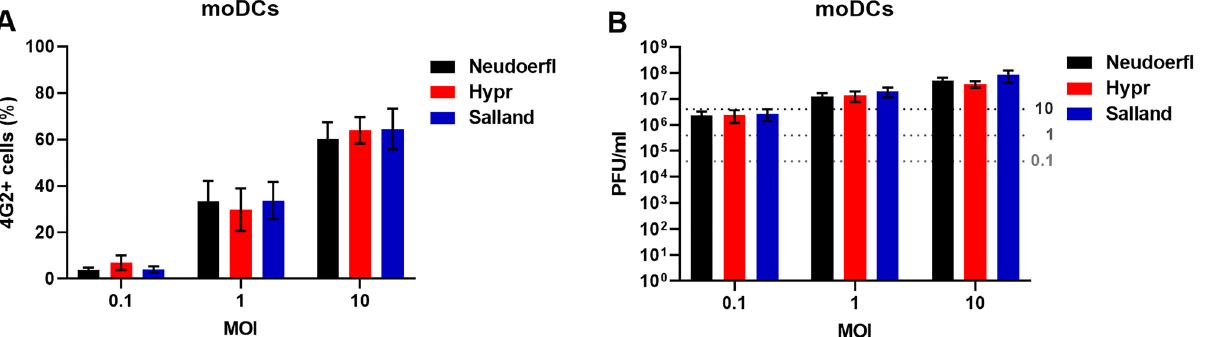
Figure 4. TBEV infection of moDCs. moDCs of three individual donors were infected with the different TBEV strains at various MOIs for 26 h. ( A ) Percentage of TBEV infected cells as quantified by fluorescent microscopy. ( B ) Infectious virus production as assessed by plaque assay. The inoculum titers per infection condition (MOI) are indicated by dashed grey lines. All values indicate average of three donors ±